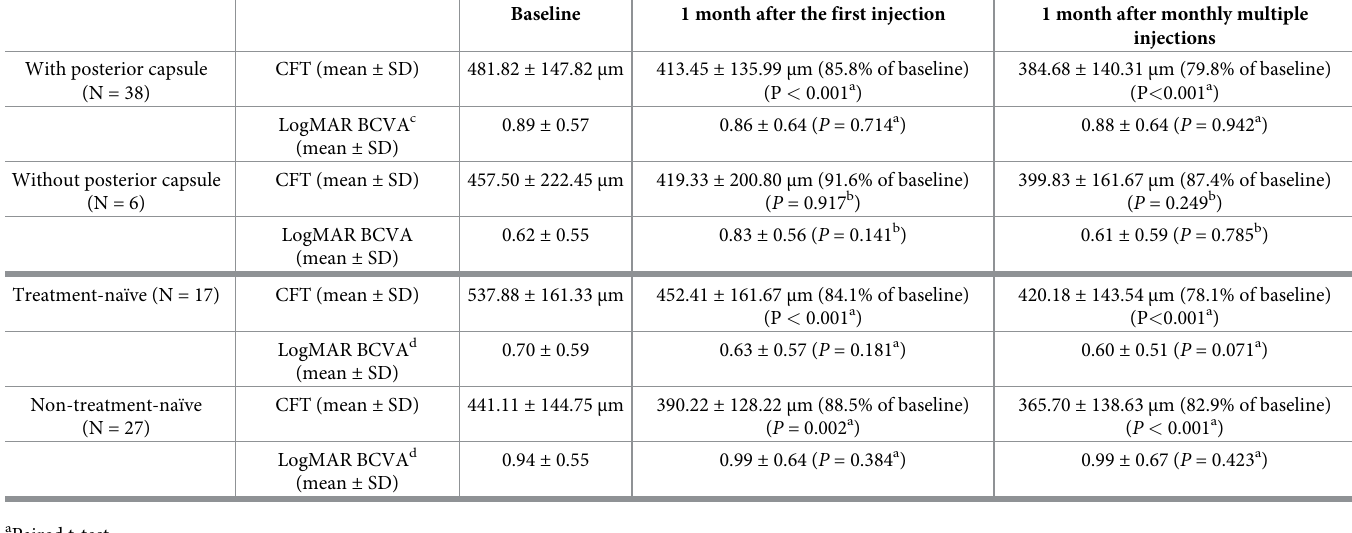
Table 5. Comparison of central foveal thickness (CFT) and logarithm of the minimum angle of resolution (LogMAR) best-corrected visual acuity (BCVA) between eyes with and without posterior capsule as well as treatment-na ï ve and non-treatment-na ï ve eyes. Baseline 1 month after the first injection 1 month after monthly multiple